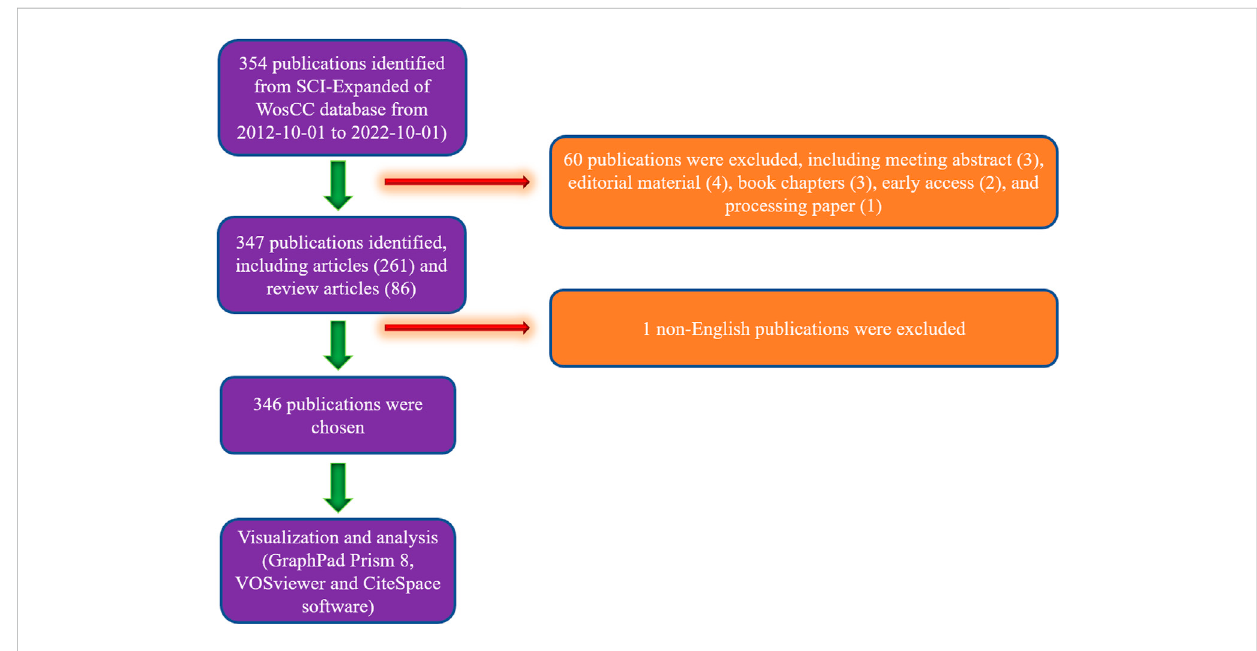
FIGURE 1 Flowchart depicting the article selection